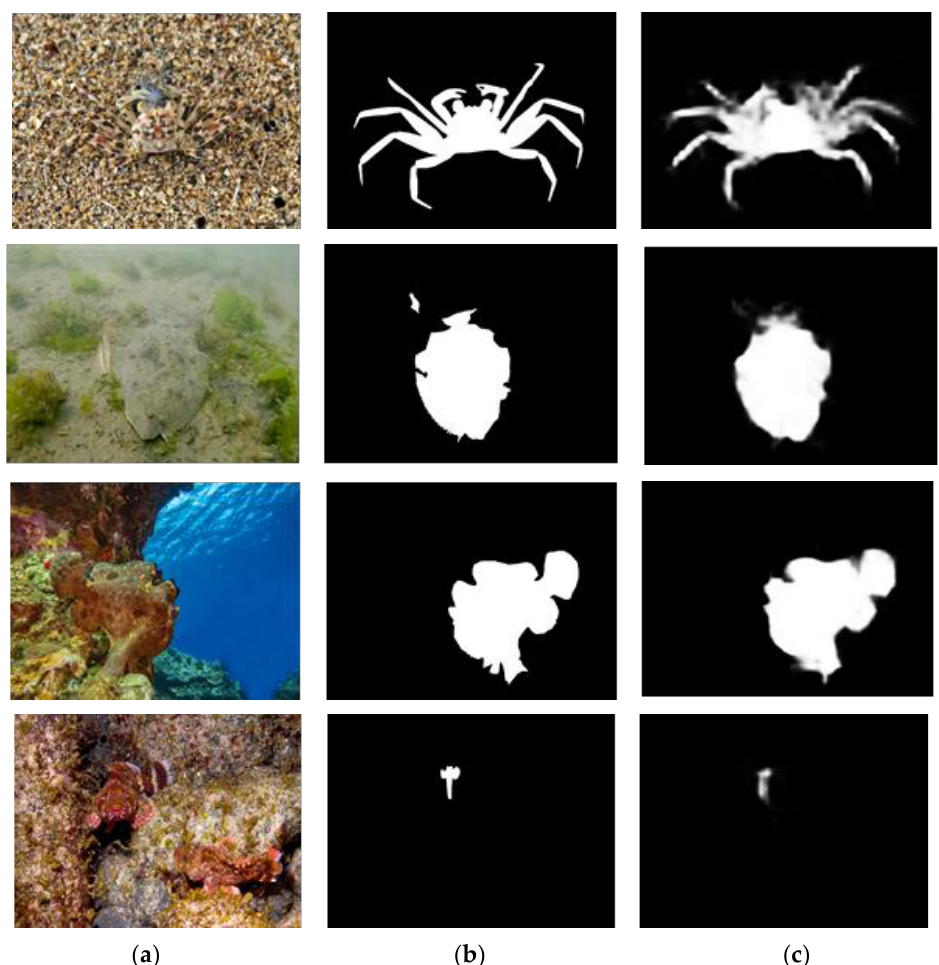
Figure 9. Comparative Analysis of multiple datasets: ( a ) CAMO; ( b ) COD10K; ( c ) Kvasir-SEG.